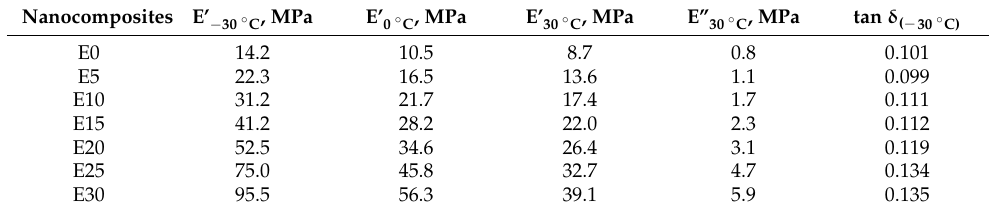
Figure 4. DMA curves of nanocomposites: ( a ) storage modulus and ( b ) loss modulus vs. temperature. Table 1. Storage (E’) and loss modulus (E”) of the nanocomposites at different temperatures .